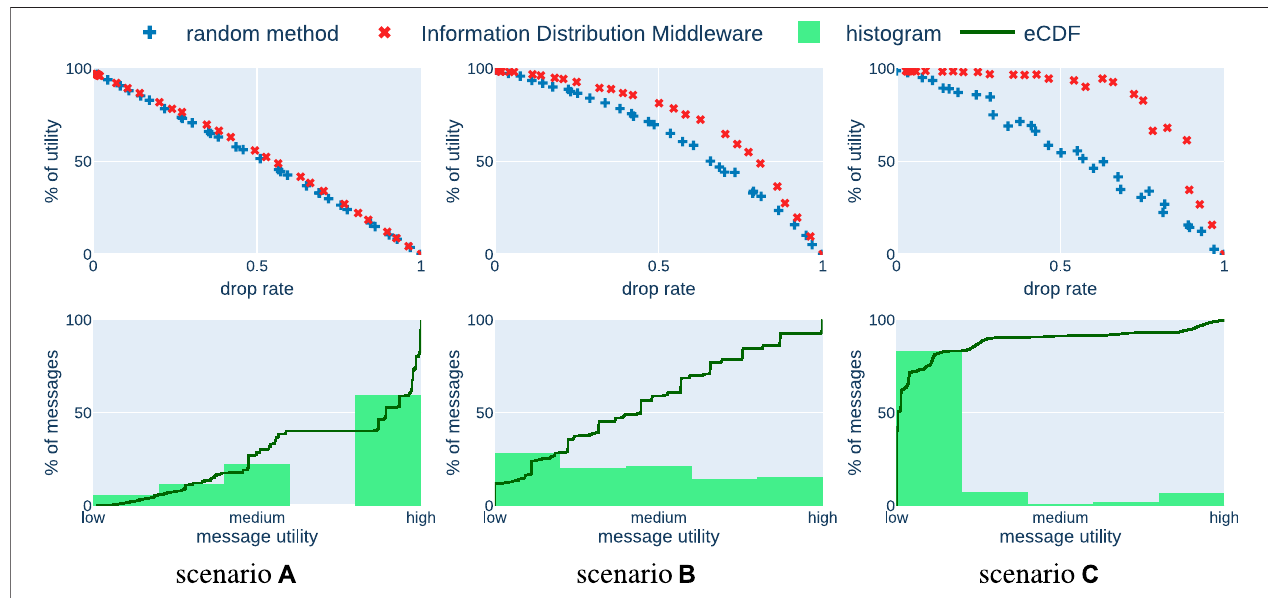
FIGURE3| Results ofcomparison between thebaselinerandom method and theInformation Distribution Middleware inthe simulation study. In scenario (A) most of the exchanged messages are of high utility. In scenario (B) there is a uniform distribution of messages with respect to utility. Finally, in scenario (C) most of the messages are of low utility. These plots can be reproduced by running the DropRateVsUtility experiment in our software framework (Barci´s, 2020).